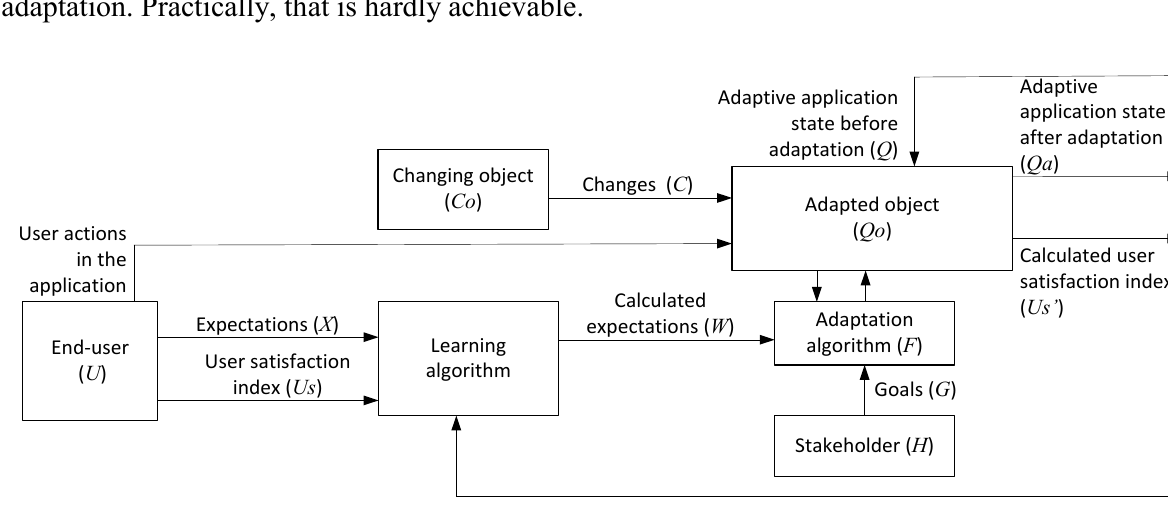
Figure 3. An extended input/output view for the core concepts of the adaptive